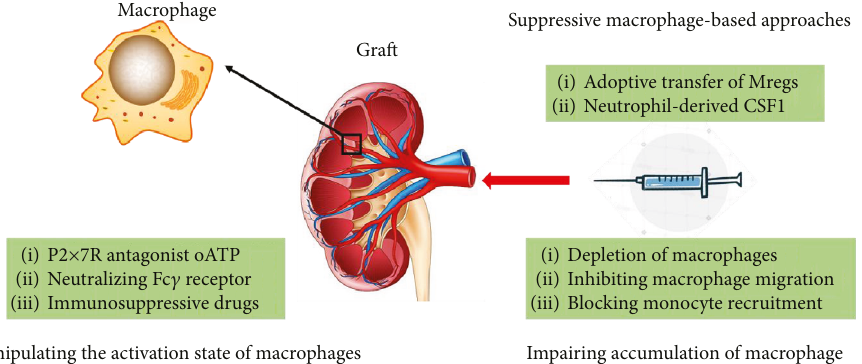
Figure 2: Macrophage-targeted therapy for transplant tolerance. Mregs are generated from bone marrow precursors in rodents or from monocytes in humans. Both the adoptive transfer of Mregs and the expansion of Mregs with neutrophil-derived CSF1 in vivo inhibit the anti-donor T-cell response. Alternatively, strategies that prevent the accumulation of macrophages within allografts, including depletion of macrophages, inhibition of macrophage migration, and blockade of monocyte recruitment, also promote graft survival and contribute to graft acceptance. Strategies suppressing the activation of macrophages with detrimental functions involved in alloimmunity might be an e ff ective therapy, such as inhibiting M2 polarization with the P2x7R antagonist oATP. Moreover, either neutralization of the Fc γ receptor or treatment with several immunosuppressive drugs (glucocorticoids, rapamycin inhibitors, and mycophenolate mofetil) exerts suppressive e ff ects on proin fl ammatory macrophages and prolongs graft